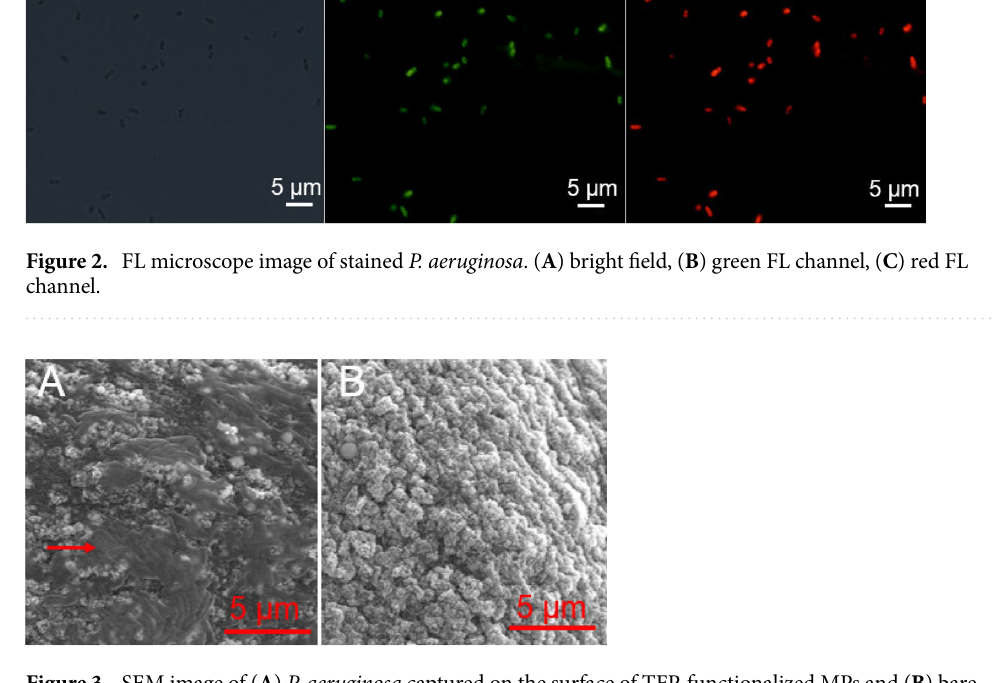
Figure 3. SEM image of ( A ) P. aeruginosa captured on the surface of TFP-functionalized MPs and ( B ) bare surface of TFP-functionalized MPs. The red arrow shows the captured P. aeruginosa